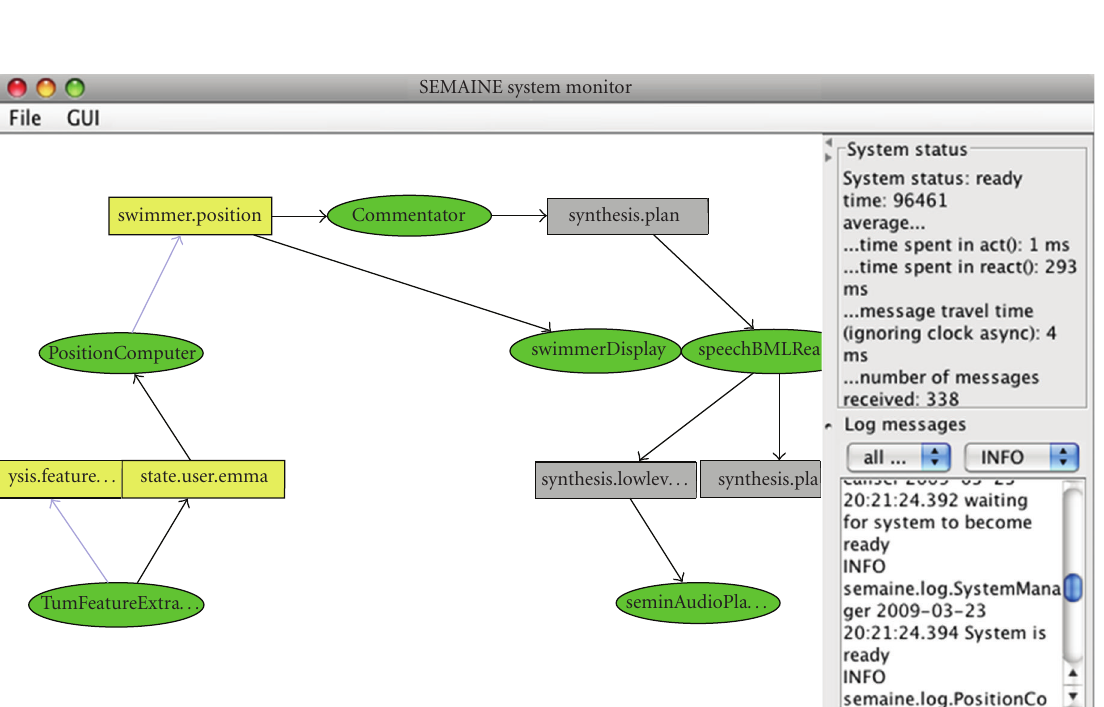
Figure 22: The Commentator component, producing TTS requests.